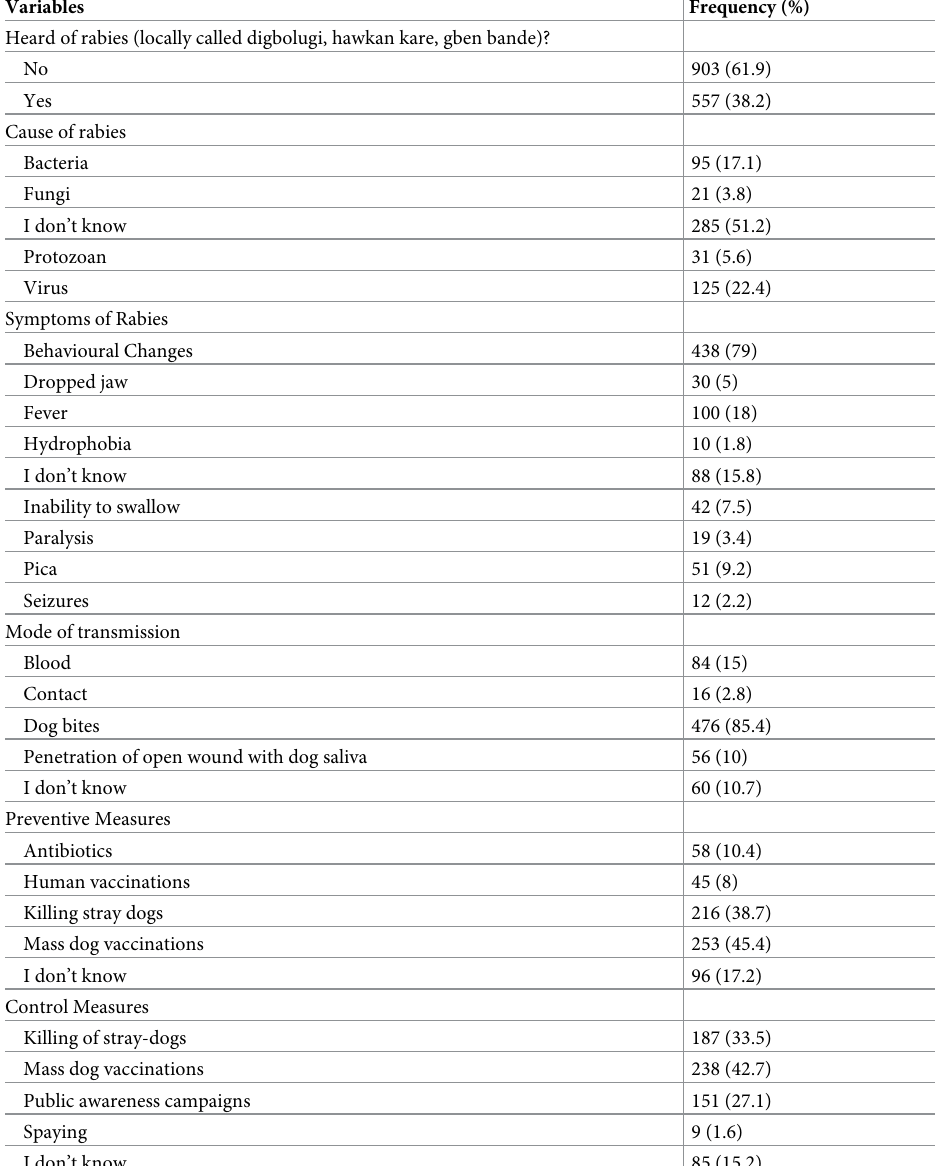
Table 1. Rabies awareness and knowledge among residents of Kwara state (n = 1460).